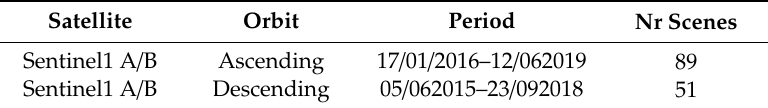
Table 1. Synthetic aperture radar (SAR) data stacks analyzed in this study. Satellite Orbit Period Nr Scenes Sentinel1 A / B